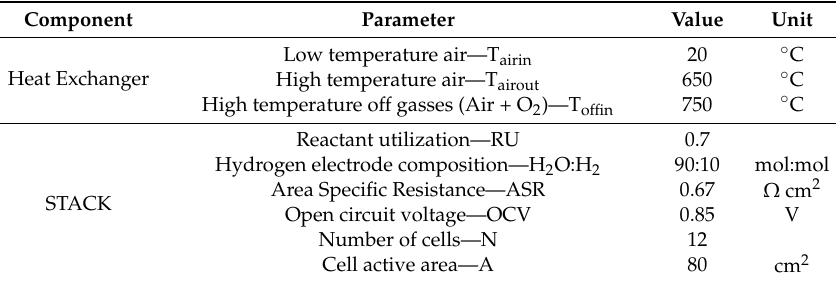
Table 1. List of constant parameters used in the